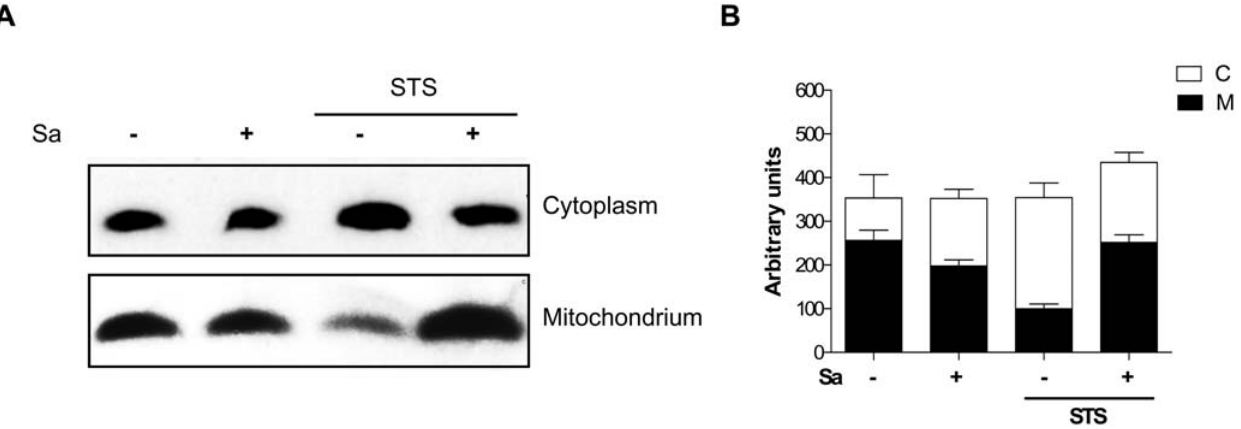
Figure 6. The infection of hMDMs with S.aureus prevents STS-stimulated cytochrome c release into the cytoplasm. Infected and control hMDMs were incubated with STS for 3 h and mitochondrial and cytosolic fractions were prepared as described in the Materials and Methods. ( A ) A representative immunoblot selected from four separate experiments. Cytochrome c was visualized by Western Blotting using anti-cytochrome c specific antibodies. Purity of fractions was , 70% as assessed by anti- b -actin and anti-COX IV antibody (data not shown). ( B ) Individual band intensity acquired by blot scanning and expressed in arbitrary units.